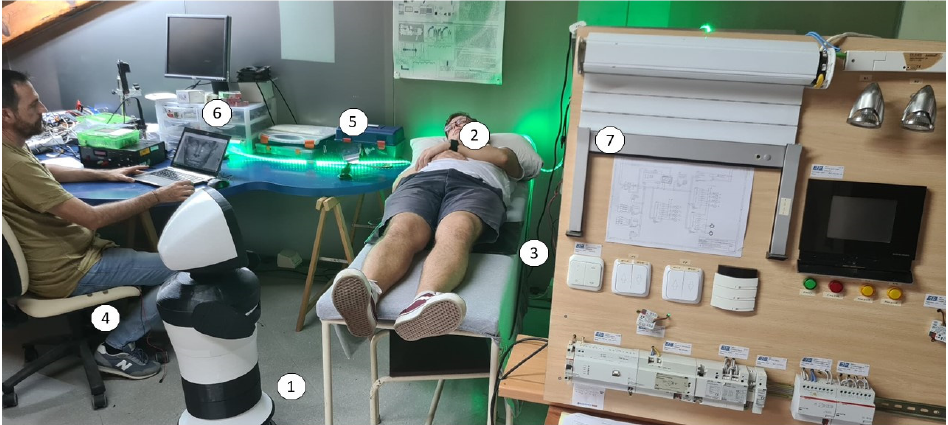
Figure 20. “Start of the day” test scenario: (1) Echo robot: 3D-printed Turtlebot base with Echo 8 and Alexa on head; (2) subject wearing the Empatica E4; (3) presence detector in bed; (4) presence detector in chair; (5) AAL user interface; (6) simulation of attention-status detection when viewing TV; (7) simulator of other home automation elements.